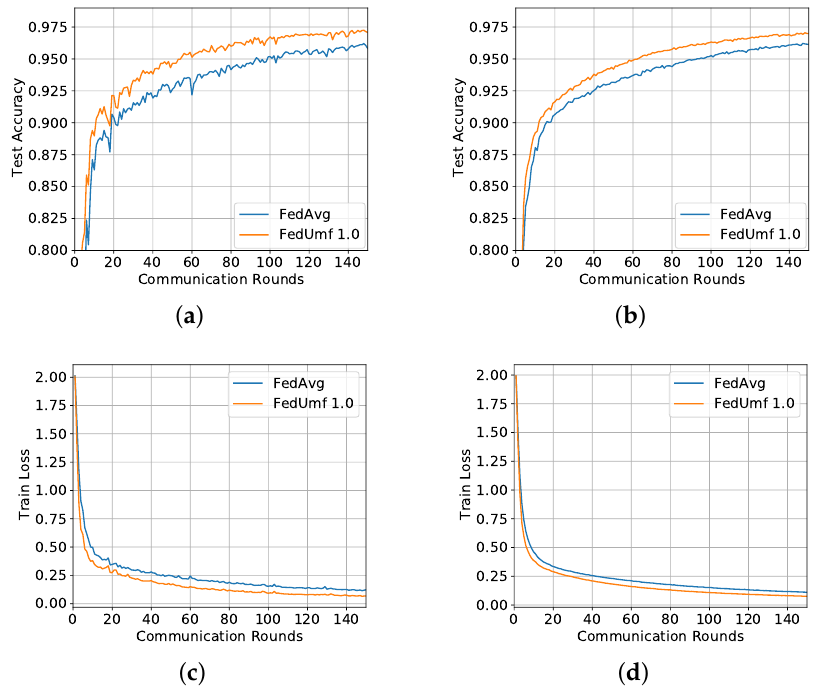
Figure 5. Server test accuracy, and client-side training loss curve performance, non-IID partition and η = 0.01 on MNIST. ( a ) Test accuracy. C = 0.1. ( b ) Test accuracy. C = 0.5. ( c ) Training loss. C = 0.1. ( d ) Training loss. C = 0.5.